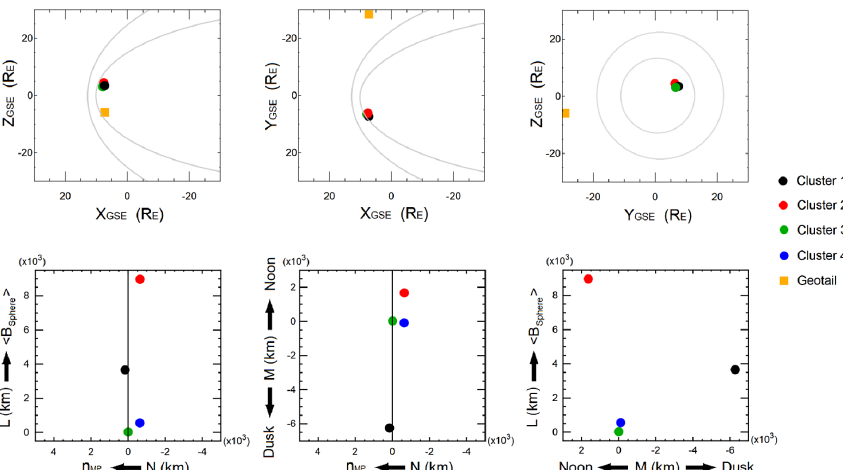
Figure 1. Position of Cluster and Geotail in GSE and LMN coordinates. Top three panels: the location of the Cluster spacecraft at (7.95, 6.55, 2.95) R E and Geotail at (7.24, − 29, − 5.19) R E at 10:10UT in (respectively from left to right) the GSE coordinate system XZ , XY and YZ planes. The grey lines demonstrate cuts of the model magnetopause based on the solar wind condition (Roelof and Sibeck, 1993, 1994) and bow shock on those planes. Bottom three panels: the configuration of the Cluster tetrahedron in the boundary normal coordinate system derived from the model with C3 as the reference spacecraft. The grey vertical lines represent the nominal magnetopause boundary. The projections of the four spacecraft locations are shown on the LN , MN and LM planes, from left to right respectively, where N represents the outbound normal to the